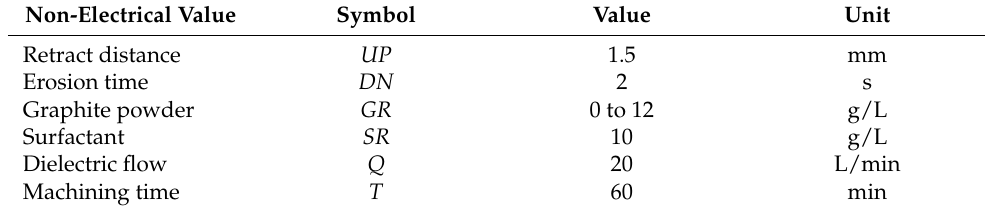
Table 2. Non-electrical